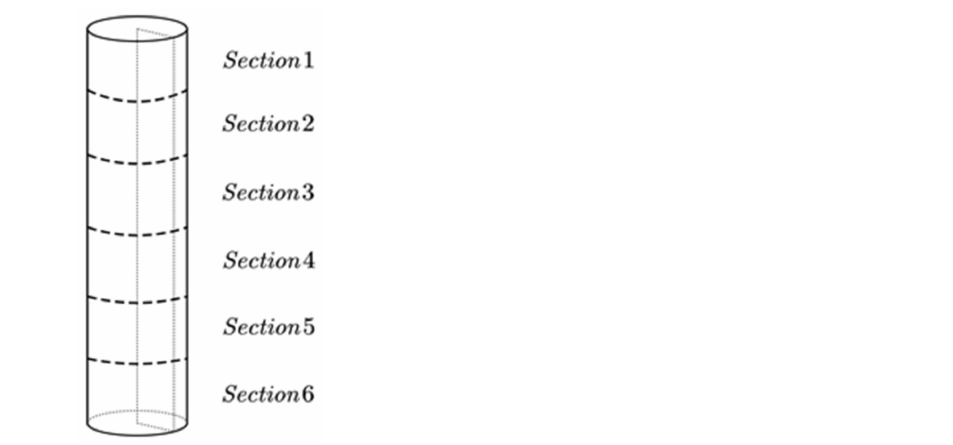
Figure 5. Waveform comparison chart.